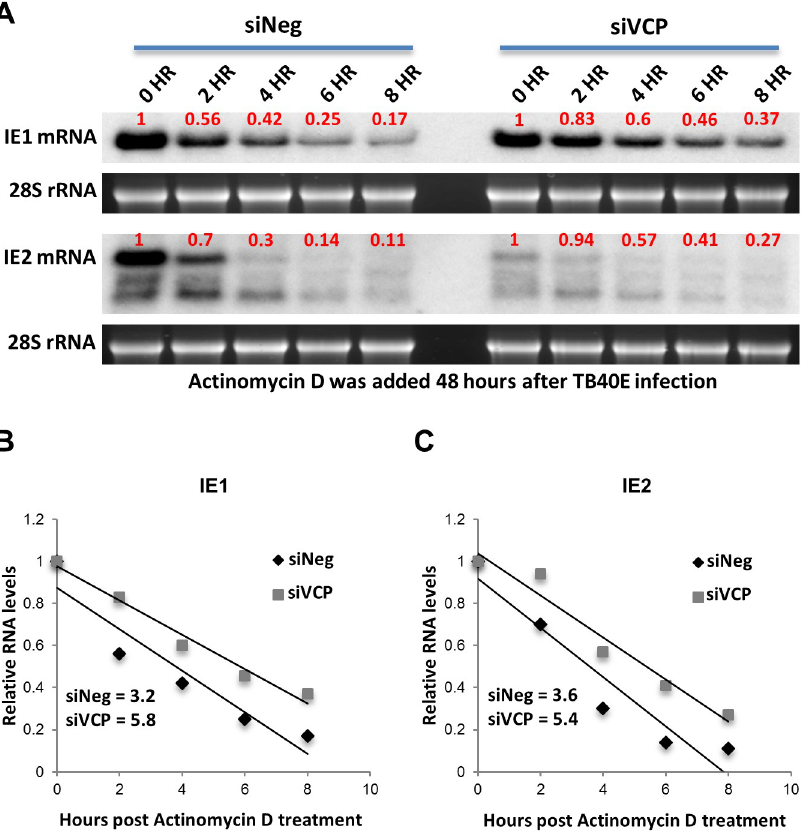
Fig 5. Knockdown of VCP does not reduce IE2 transcript stability. (A) Fibroblast cells were transfected with siRNA againstVCP or negativecontrol siRNA and infected with HCMV 48 hours post transfection. Forty-eight HPI cells were treated with actinomycin D to inhibit transcription and total RNA harvestedat the indicatedtime points. Stability of IE1 and IE2 transcript was determinedby Northern blot analysis. Bands were quantified using Image J software [54]. Quantificationof transcript levels shown in (A) were plotted and transcript half-life determined using equationsderived from linear trend lines. Knockdownof VCP results in an increasein transcript stability of 1.8 fold for IE1 (5.8 for VCP knockdown cells versus 3.2 for control cells) (B) and 1.5 fold for IE2 (5.4 for VCP knockdown versus 3.6 for control cells)